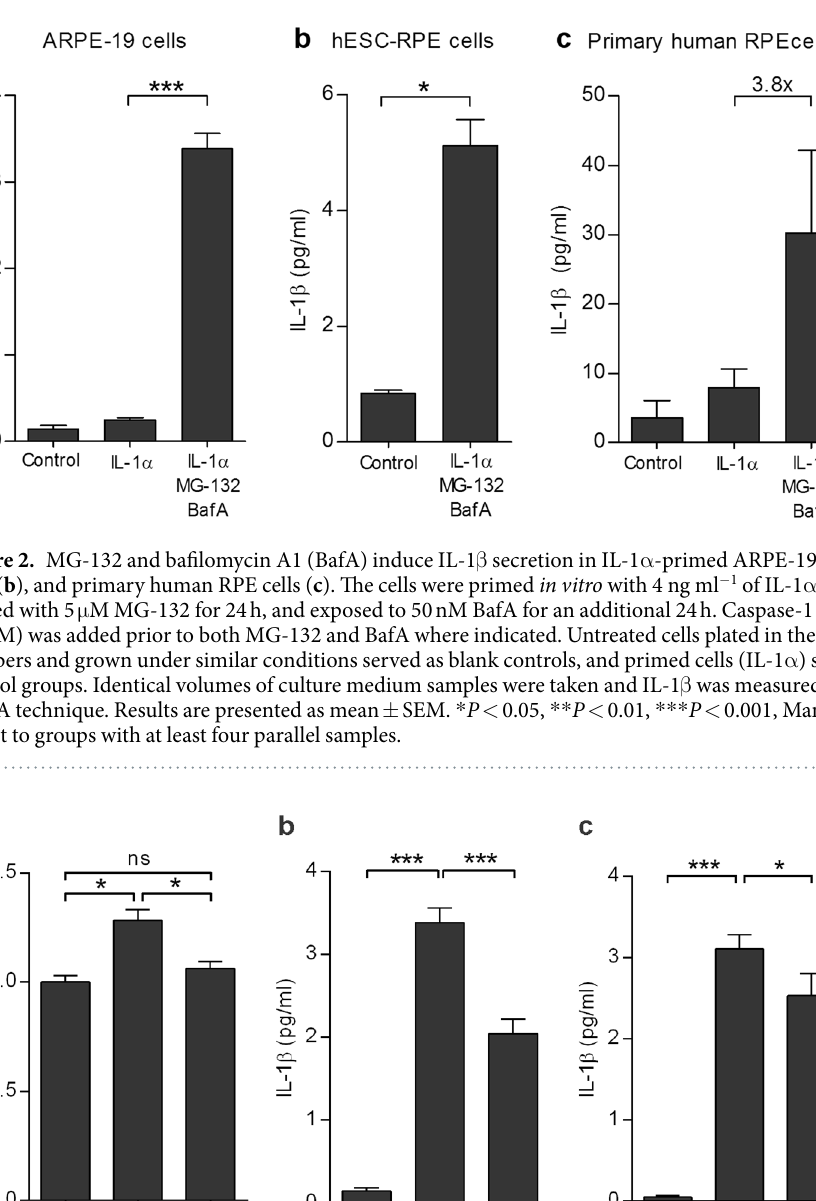
release also from IL-1 α -pre-treated primary human RPE cells when compared to primed cells alone (Fig. 2c; 30.2 ± 12.0 pg ml − 1 vs. 8.0 ± 2.6 pg ml − 1 ). It is notable that the response of hESC-RPE cells was slightly higher than that obtained with the ARPE-19 cells (5.1 ± 0.5 vs. 3.4 ± 0.2 pg ml − 1 ), while primary hRPE cells produced clearly higher levels of IL-1 β when compared to ARPE-19 or hESC-RPE cells alone (30.2 ± 12.0 pg ml − 1 ). Geldanamycin prevents the inflammasome activation in ARPE-19 and primary human RPE cells. Next, we studied the effects of Hsp90 inhibitor geldanamycin (GA) on the activation of the NLRP3 inflammas- ome. Pre-treatment of primed cells with GA resulted in decreased caspase-1 activity (Fig. 3a) and reduced IL-1 β release (Fig. 3b) in ARPE-19 cells exposed to MG-132 + BafA. The finding was also verified by replacing the